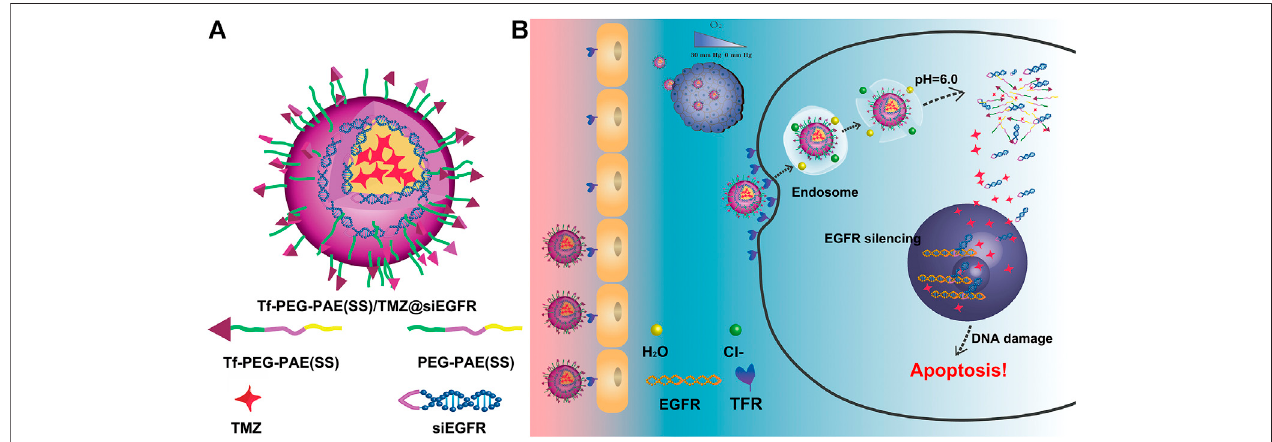
FIGURE 1 | Schematic illustration of the Tf-PEG-PAE(SS)/TMZ@siEGFR micelle. (A) Main components of Tf-PEG-PAE(SS)/TMZ@siEGFR. (B) Tf-PEG-PAE(SS)/ TMZ@siEGFRnanoparticlesdramaticallygatheringliomabyTf-mediatedtranscytosisstrategyandthengetridoftheendosomereleasingsiEGFRandTMZ;thesiEGFR silences gene expression by reinforcing the anticancer effect of